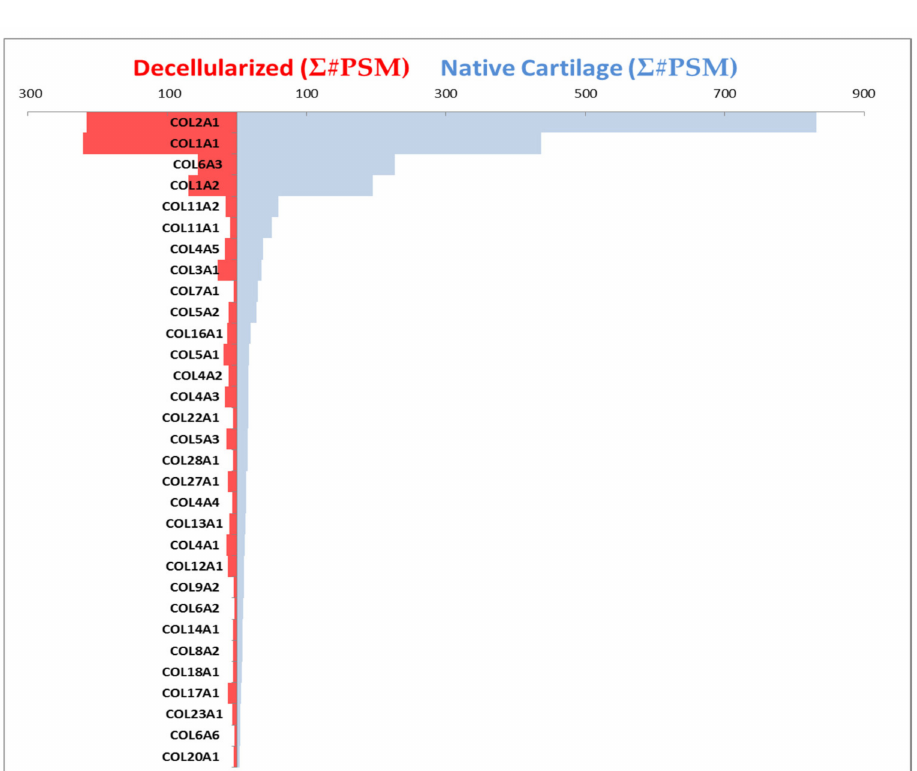
Figure 6. Collagenous composition of the decellularized scaffold. Blue bars show the collagens present in cartilage prior to the decellularization process, and red bars show composition of the scaffold after the decellularization process. The length of the bars to the left and right corresponds to abundance of the specific collagens. Collagen alpha chains are listed in the order of decreasing prevalence within native cartilage. The resulting decellularized scaffold (red) contained COL2A1, COL1A1, COL6A3, COL1A2, COL11A2, COL11A1, COL4A5, COL3A1, COL5A2, COL16A1, COL5A1, COL4A2, COL4A3, COL5A3, COL27A1, COL13A1, COL4A1, COL12A1, and COL17A1. Minor contributions of COL7A1, COL22A1, COL28A1, COL4A4, COL9A2, COL6A2, COL14A1, COL8A2, COL18A1, COL23A1, COL6A6, and COL20A1 were detected after decellularization. Horizontal axes values represent the sum of peptide spectrum matches (PSM), the total number of identified peptides for each collagen as an indication of